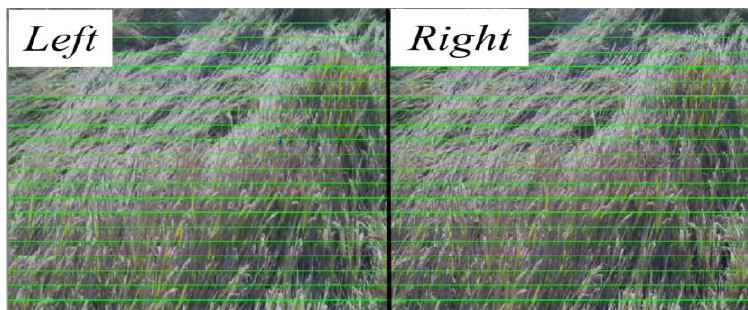
Figure 7. Wheat image. ( a )Left view with marker; ( b ) Right view with marker.